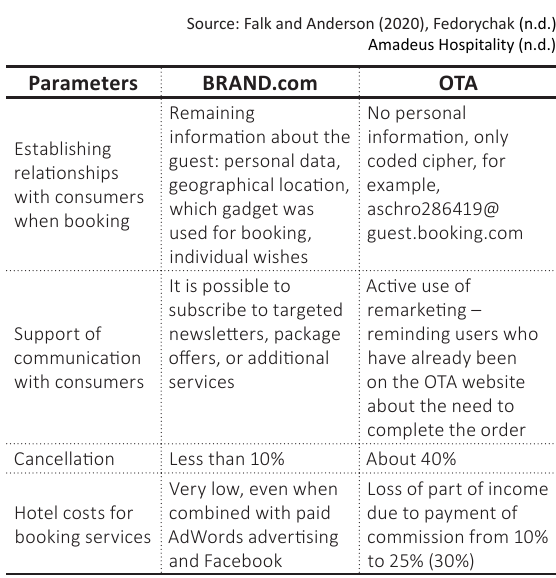
Table 1. The comparison of BRAND.com and OTA capabilities in hospitality services distribution